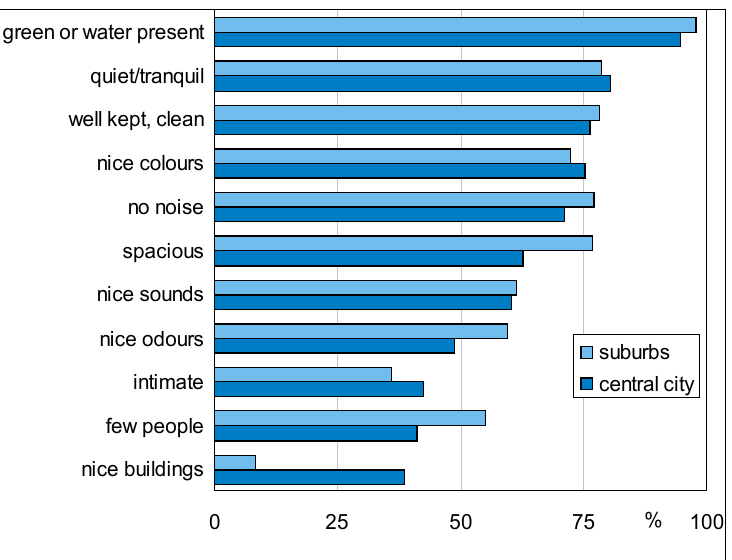
Figure 9. Percentage of respondents who think the given characteristic applies to a quiet